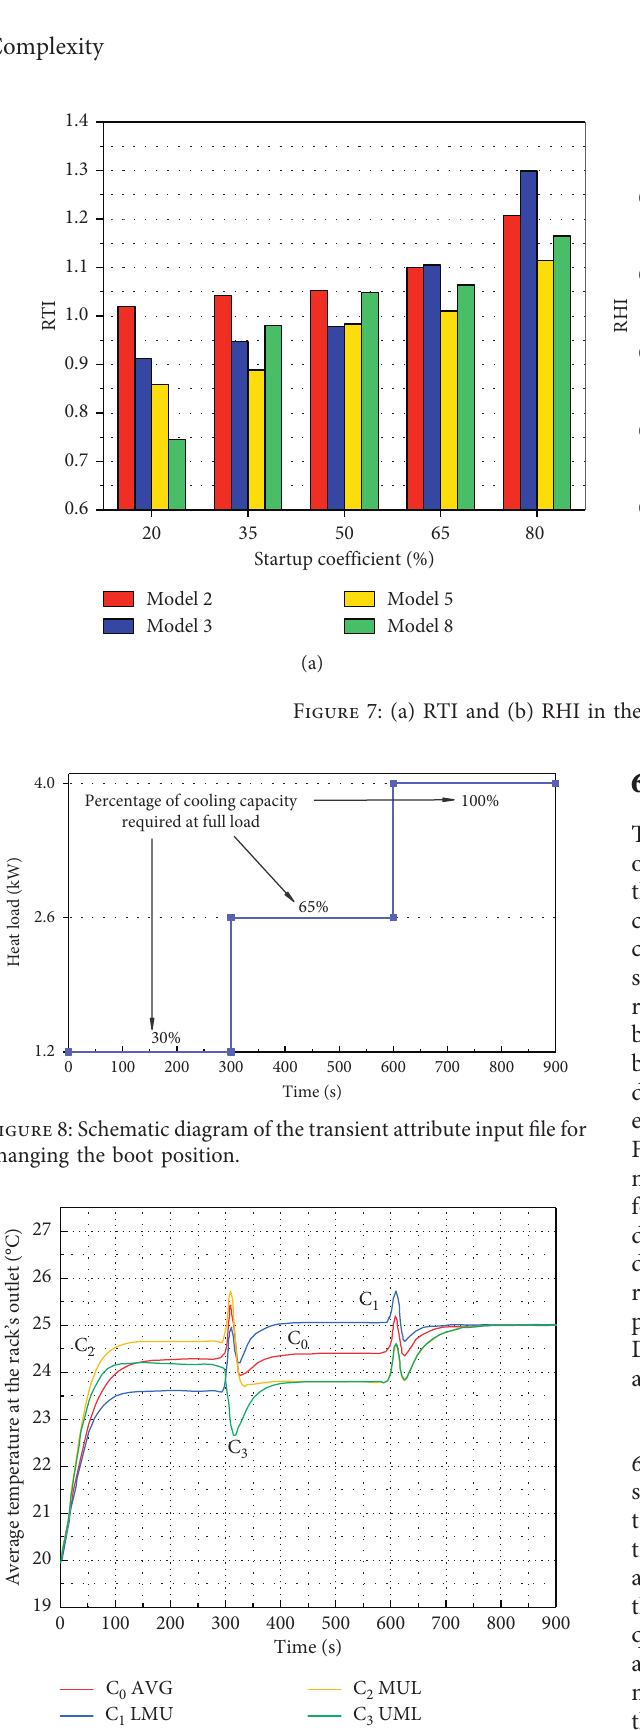
Figure 9: The average temperature at the outlet of the rack over